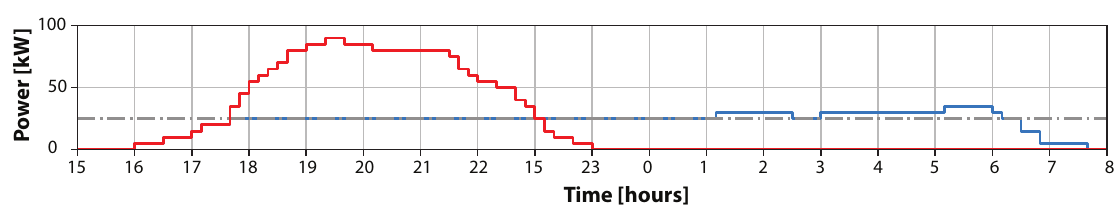
( c ) Aggregated power drawn by EV 0–19 corresponding to uncoordinated EV charging (in red), and the power allocation for the coordinated charging using earliest deadline rule with P lim “ 25 kW. Figure 4. Behavior of the EVs’ coordinated charging between 3 p.m. and 8 a.m. of the following day via the proposed packetized energy